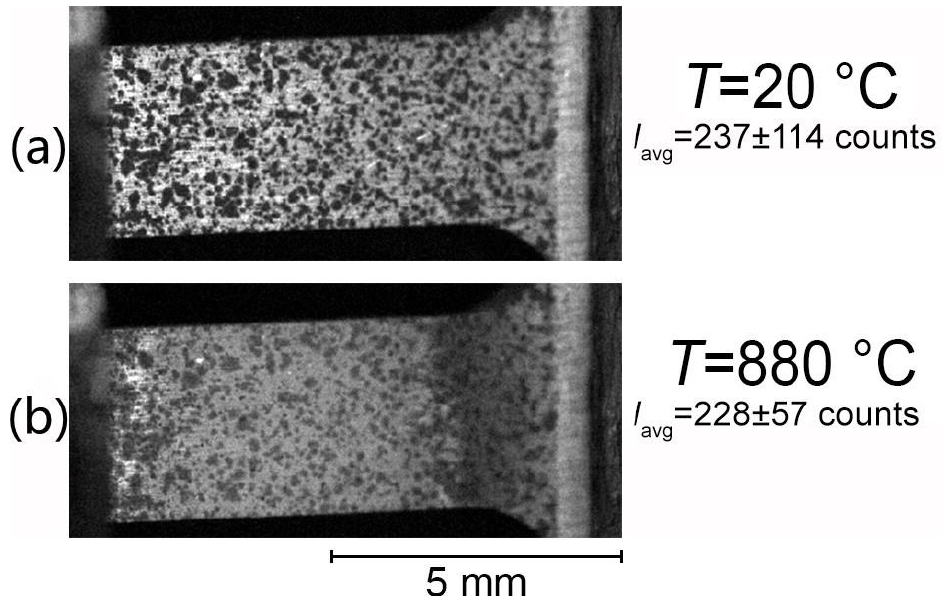
Figure 5. Optical images of spray-painted pattern at ( a ) room temperature and at ( b ) 880 ◦ C. I avg is the average light intensity from the specimen’s gauge length and the standard deviation is an indication of the contrast at a given condition (a bigger standard deviation indicates more levels of grey between black and white). These pictures were taken using the blue-green shortpass